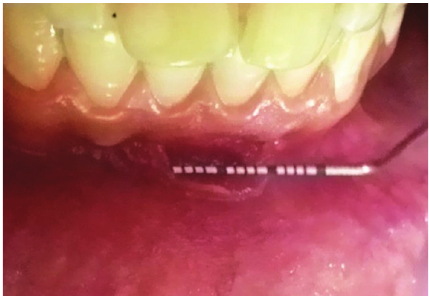
Figure 1: Case 1. Gingival clefting and recession due to scratching with fingernail in relation to tooth #41.